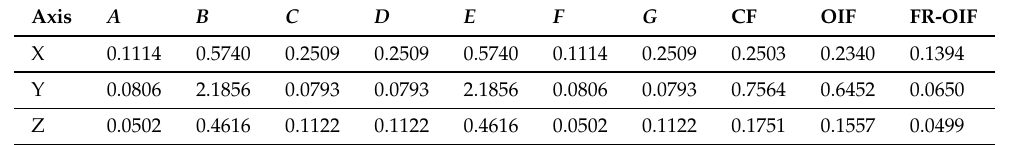
Figure 12. Variation of Semi-logarithmic root mean square error for position along X-Y-Z obtained from different fusion (CF, OIF, FR-OIF). Table 2. RMSE comparison for the estimation of the positions in meters.